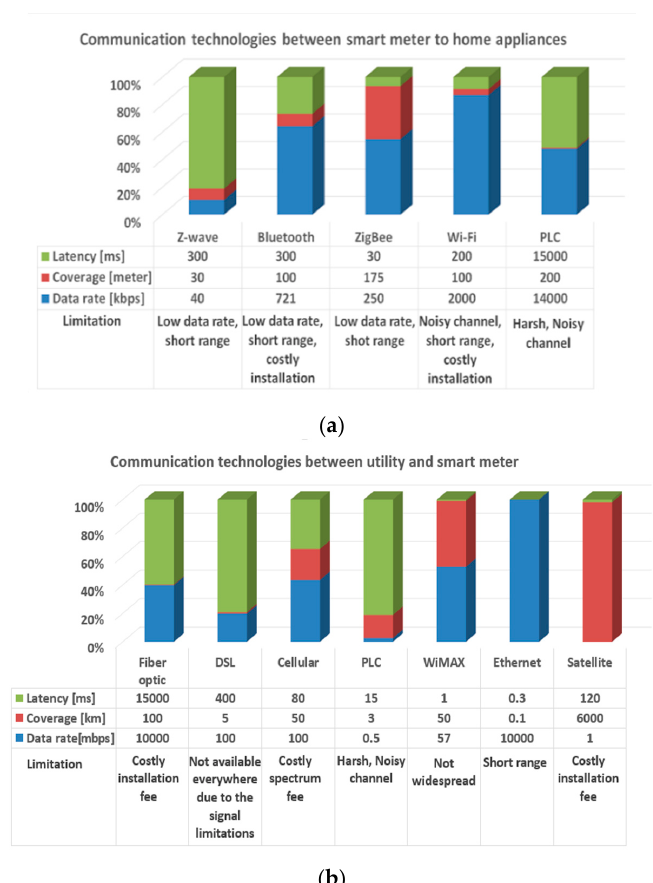
Figure 7. Comparison of different communication mediums ( a ) between smart meter to home appliances, ( b ) between utility and smart meter.